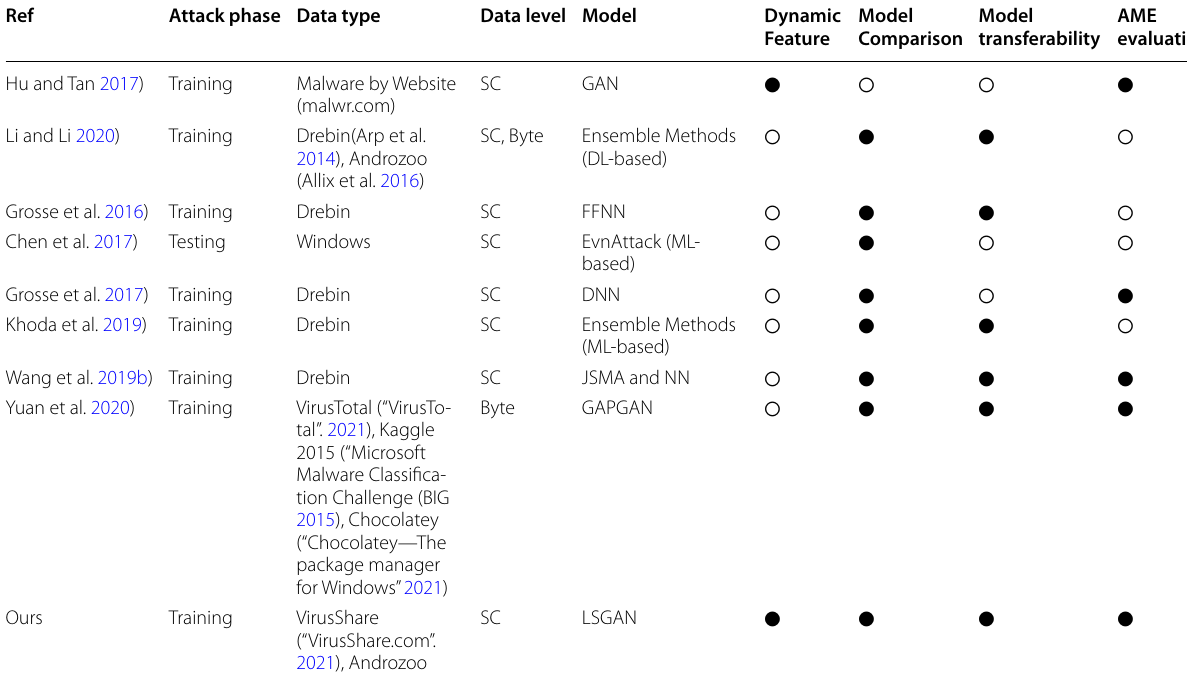
a SC Semantic characteristic b The Attack Phase includes during the training phase and during predicting/testing. The Data Type indicates the type of malware datasets such as Android and Windows malware. The Data Level displays the feature type of data, mainly including semantic characteristic, byte, and pixel. The Model demonstrates the trained model pattern including DL-based models and conventional ML-based models. The Approach exposes the overview of the specific method. The Dynamic Feature is used to analyze whether the paper uses dynamic malware features to avoid code obfuscation. The Model Comparison represents whether the paper makes the comparison. The Model Transferability indicates whether the paper attack other detectors using AME generated by themselves. The AME Evaluation denotes whether the reference paper makes the adversarial malware example performance